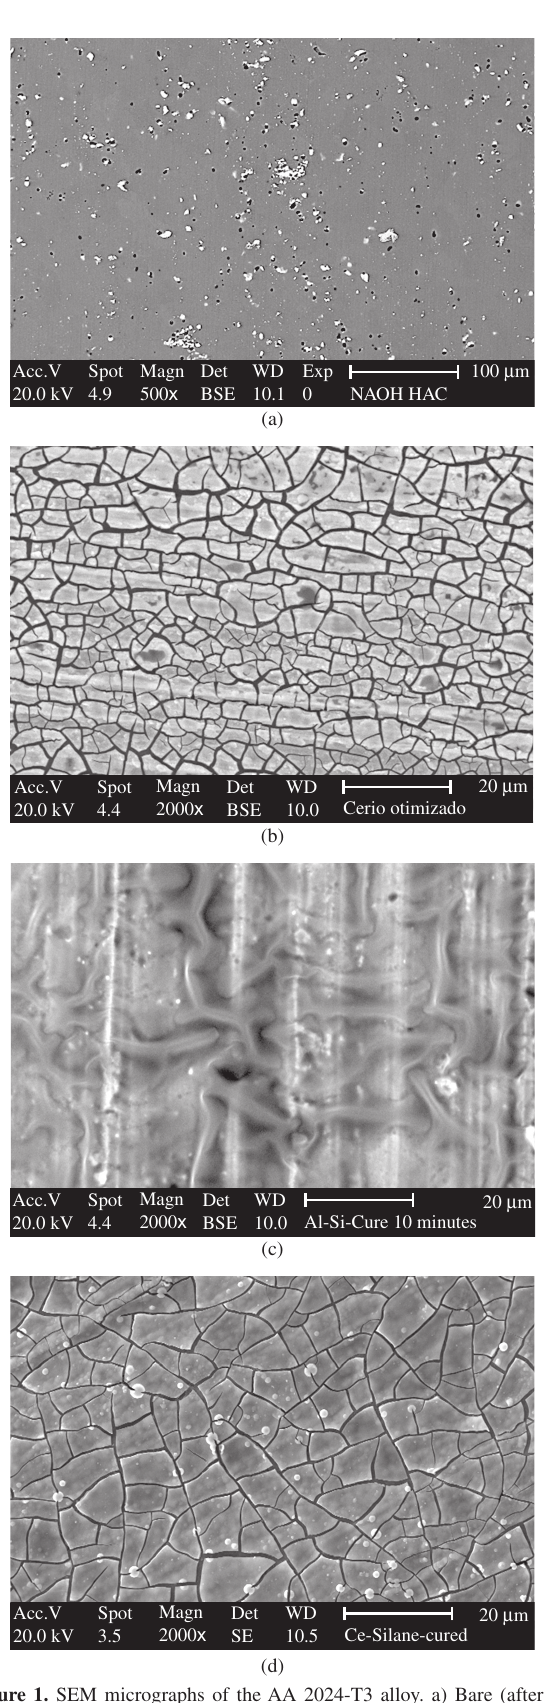
Figure 1. SEM micrographs of the AA 2024-T3 alloy. a) Bare (after the standard pre-treatment); b) Cerium coated; c) Silane coated; and d) Cerium- silane coated (cured).